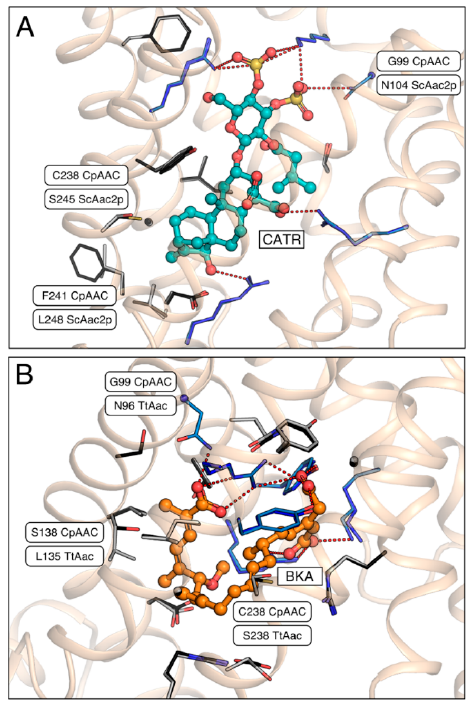
Figure 5. Carboxyatractyloside and bongkrekic acid binding to CpAAC. ( A ) Bound